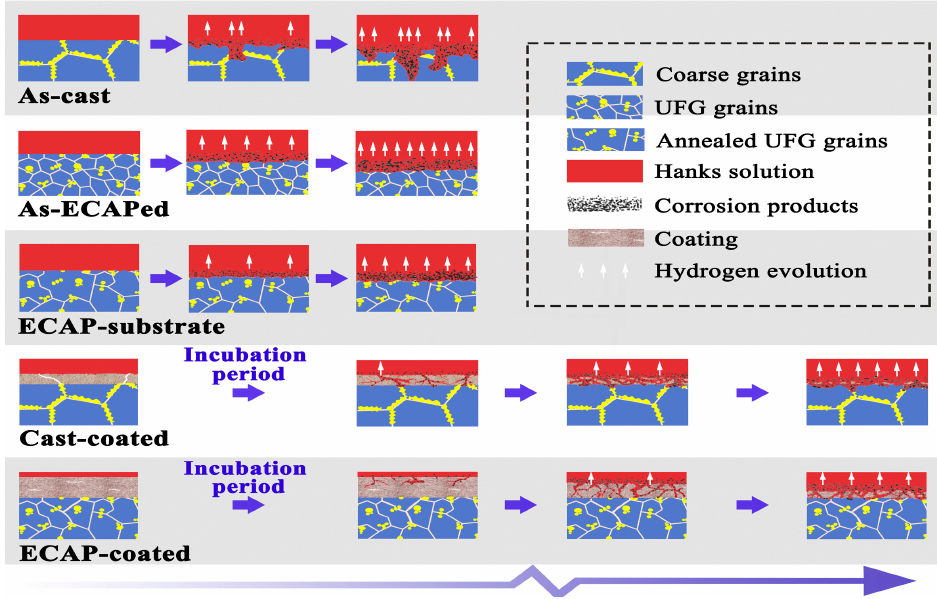
Figure 6. Schematics of corrosion degradation process and the corresponding microstructure alter- ation in all samples [98]. Reprinted with permission from ref. [98]. Copyright 2022 Elsevier.